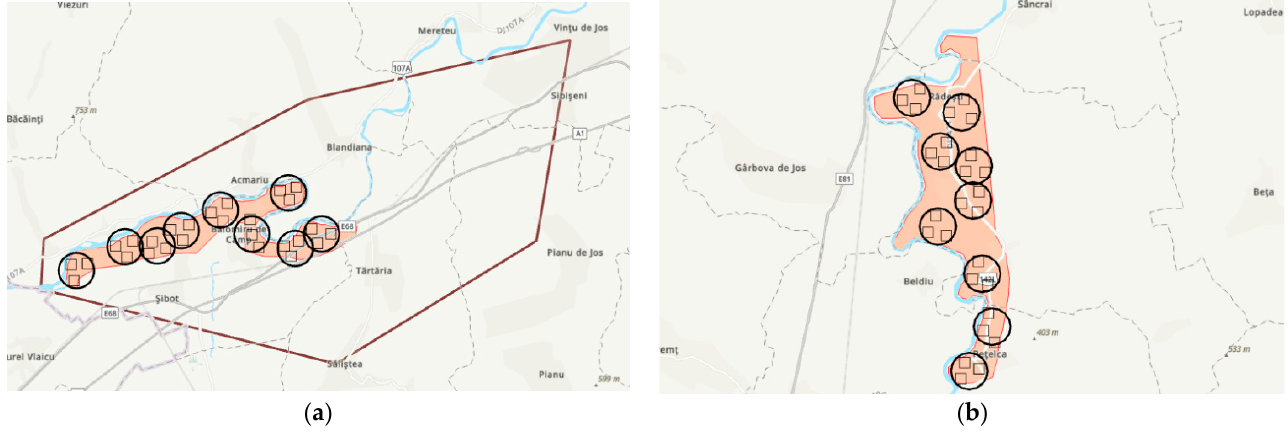
Figure 2. Sampling design: ( a ) A1—Research area inside the N2000 network. The area marked with a brown color line represents the delineation of the N2000 site. The land surface colored with brown represents the research area inside the N2000 site (A1). ( b ) A2—Research area outside the N2000 network. The circles found within the two research areas represent the 9 polygons/research area investigated, while the small quadrats found inside the circles represent the 27 plots/research area inventoried. (Source: Original).